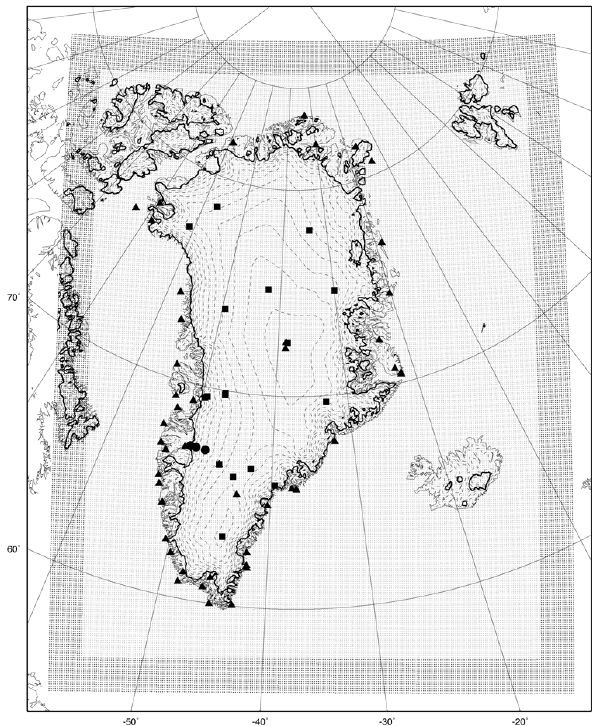
Fig. 1. Map of Greenland featuring the model domain, relaxation borders (the outer 16 grid points represented as dark gray dots), lo- cation of model grid points (light gray dots) and location of observa- tional sites. The 51 DMI climate stations are indicated by triangles, the 15 GC-net automatic weather stations by squares and the three K-transect AWSs by circles. Thin dashed lines are 250m elevation contours from Bamber et al. (2001). The thick black line represents the ice sheet contour as used in